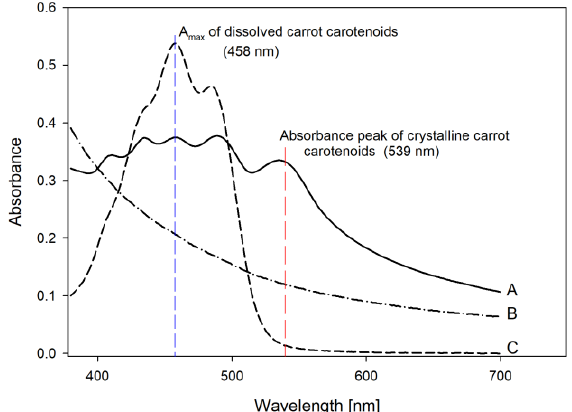
Figure 2. UV/Vis spectra of carrot carotenoids in sugar solution (A), the baseline measured after carotenoid extraction (B) and dissolved carrot carotenoids in sunflower oil (C).